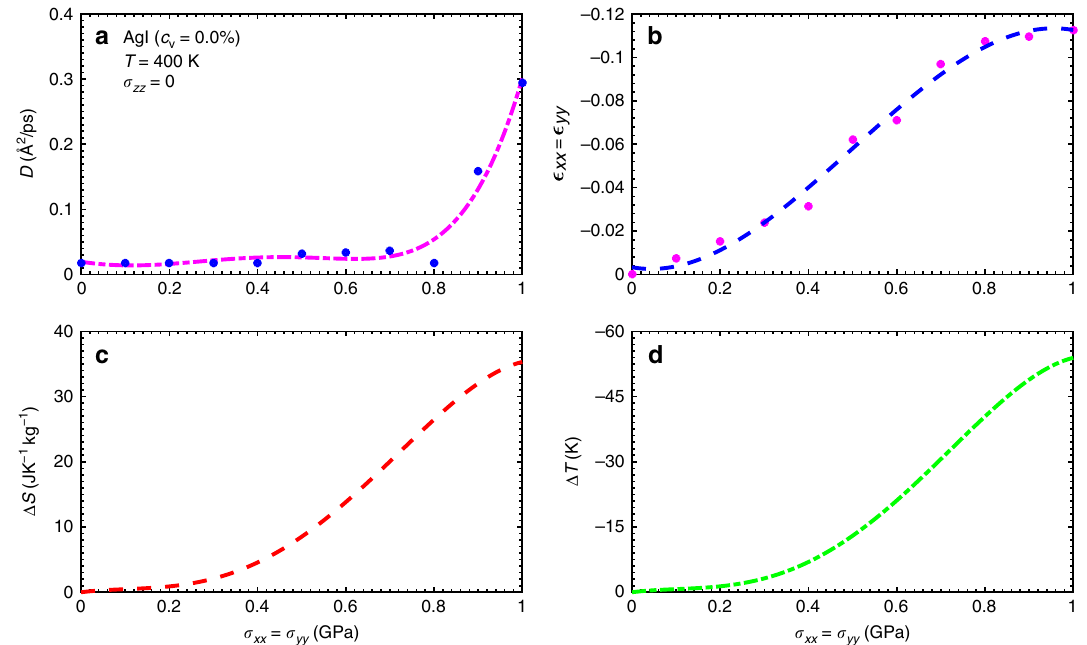
Fig. 5 Mechanocaloric effect in the AgI superionic conductor without vacancies at T = 400 K. The Ag + diffusion coef fi cient a , in-plane strain b , isothermal entropy shift c , and adiabatic temperature change d estimated at high temperature and expressed as a function of biaxial (compressive) stress. Lines in a , b are guides to the Figs. 7 – 9 (e.g., ionic mean squared displacement and density distribution plots), with the presence of atomic disorder in the